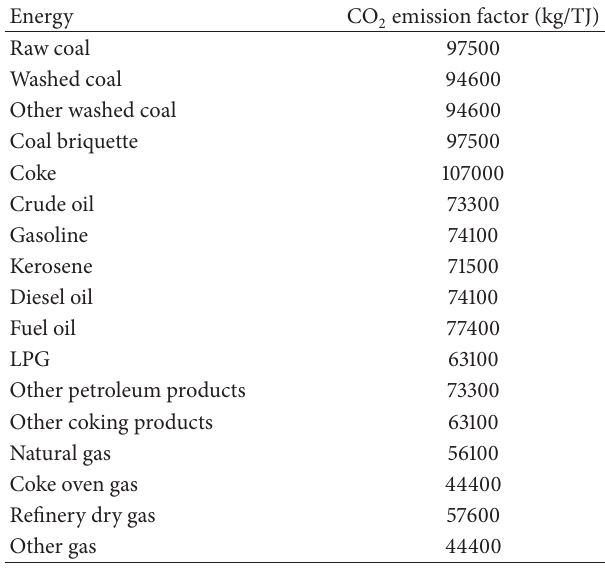
Table 3: CO emission factors by kinds of energy. 2